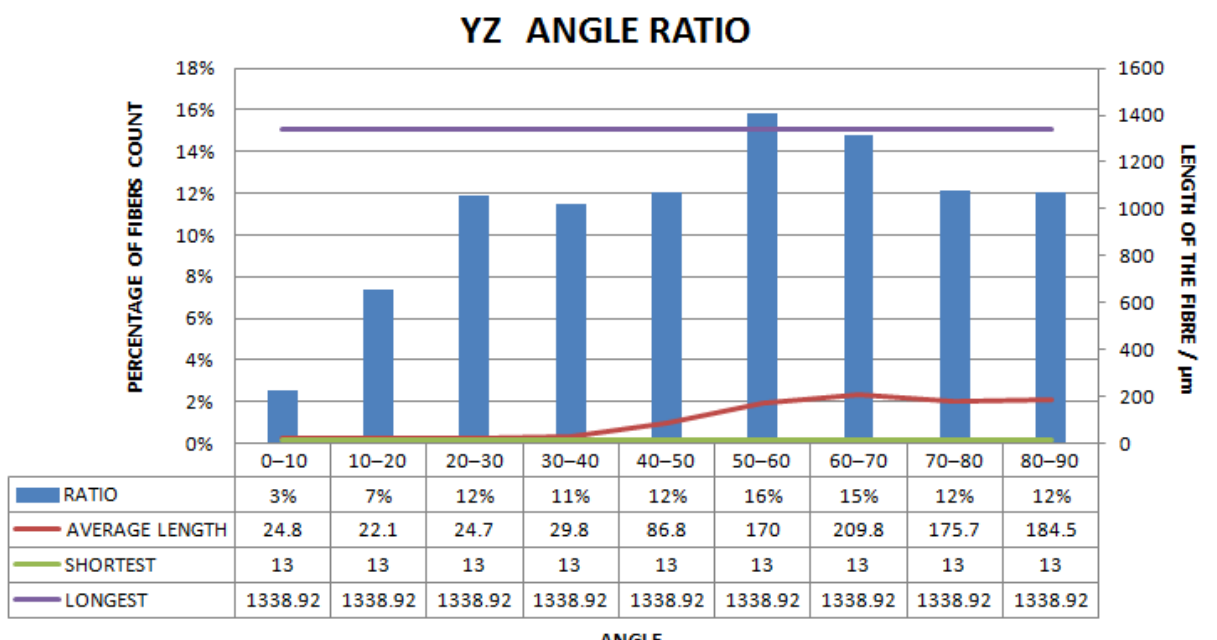
Figure 23. Statistical diagram of the angle between polyester short fibers reconstructed by Avizo software and the YZ direction